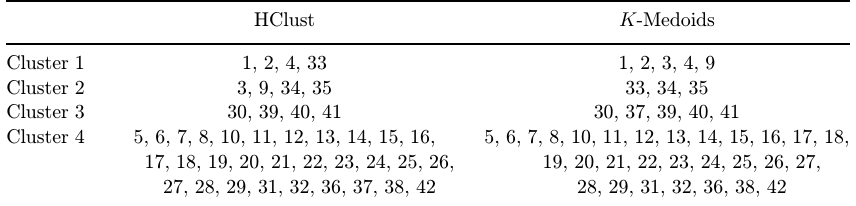
Table 5. Comparative table using itemset as descriptor of textual data.